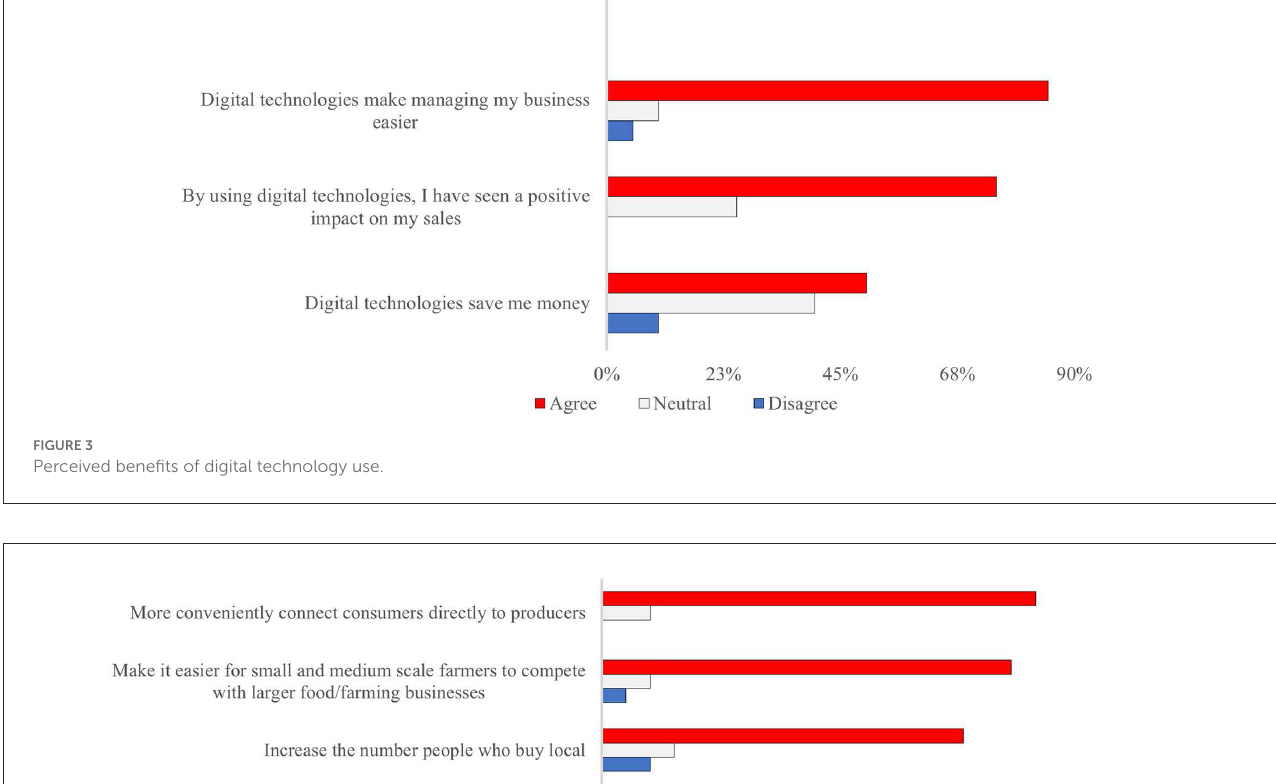
using digital tools in local food systems: “Food transparency and food safety. Origins of local